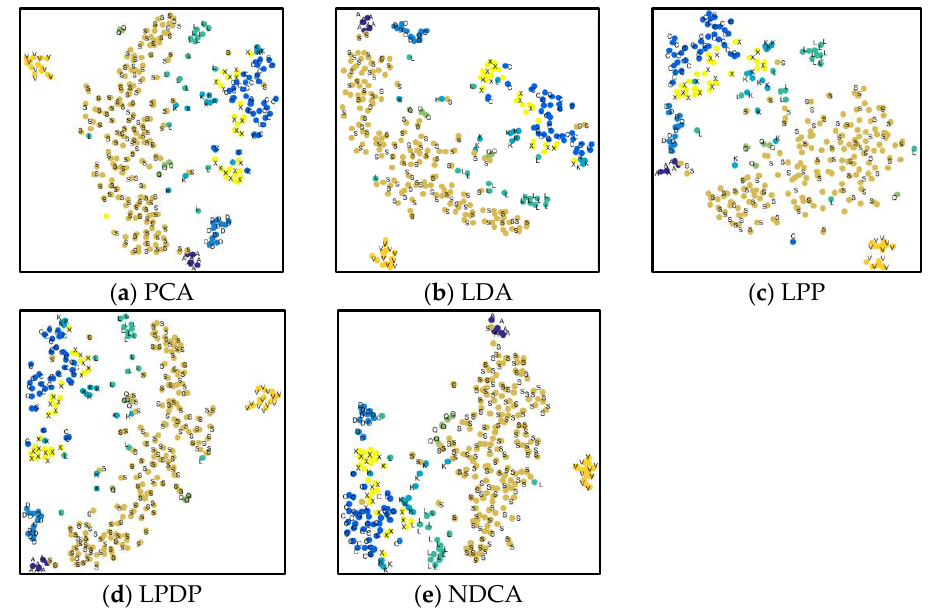
Figure 10. Visualization for the scatter points of the first two components acquired by different methods. By comparison, the proposed NDCA model shows better within-class compactness and between-class separation characteristics.